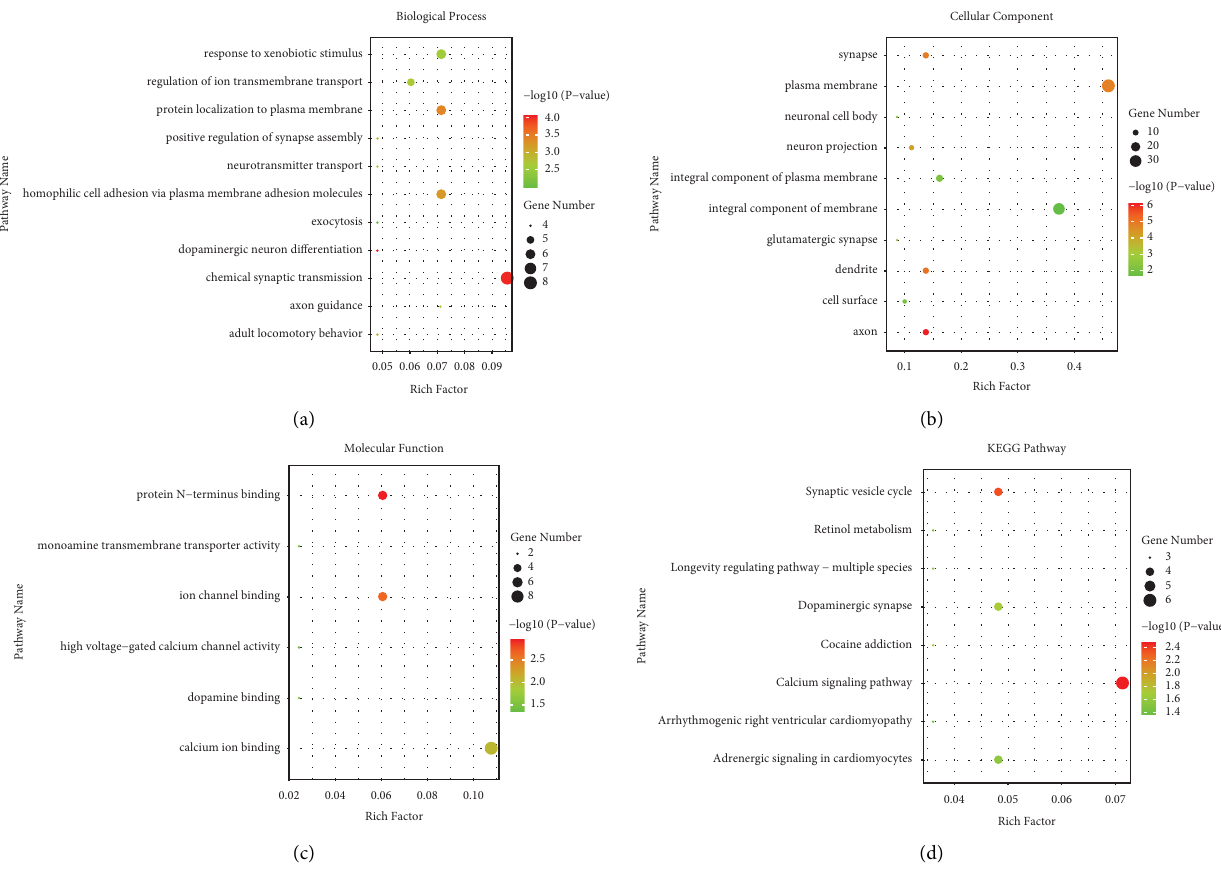
Figure 3: Functional enrichment of common DEGs between GSE49036 and GSE7621. (a) BP, biological process. (b) CC, cellular component. (c) MF, molecular function. (d) KEGG pathway enrichment analysis. DEGs, diferentially expressed